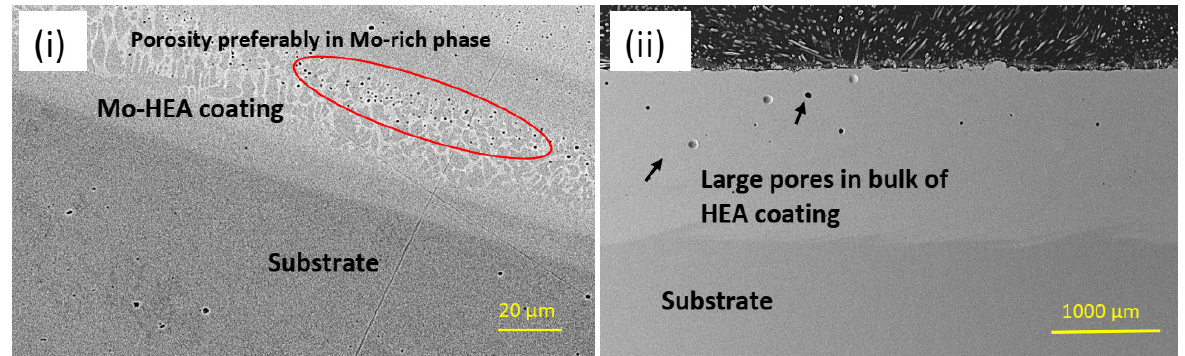
Figure 6. ( i ) A high number of pores was observed in the Mo-HEA coating at the substrate but ( ii ) at a lower frequency and larger volumes in the bulk coating and closer to the surface.